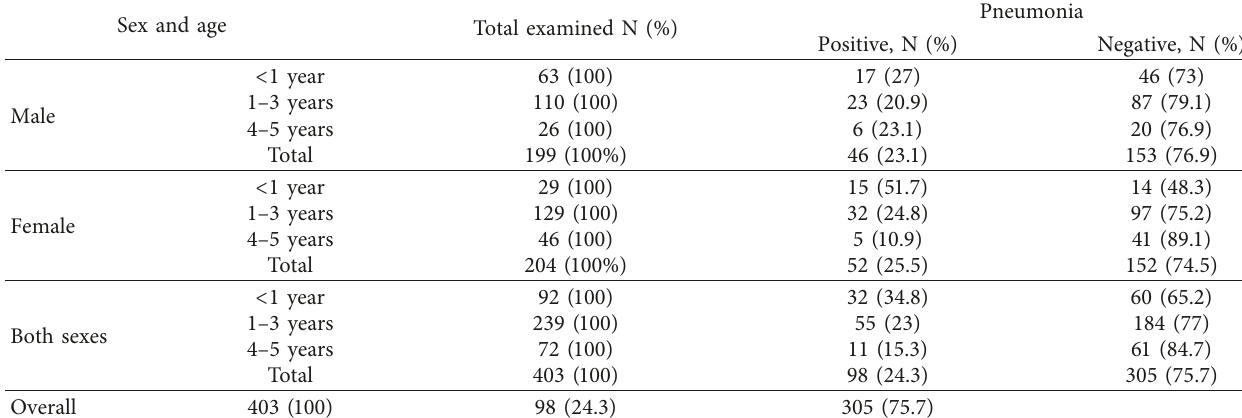
Table 2: Prevalence of pneumonia among under-five children by age and sex.